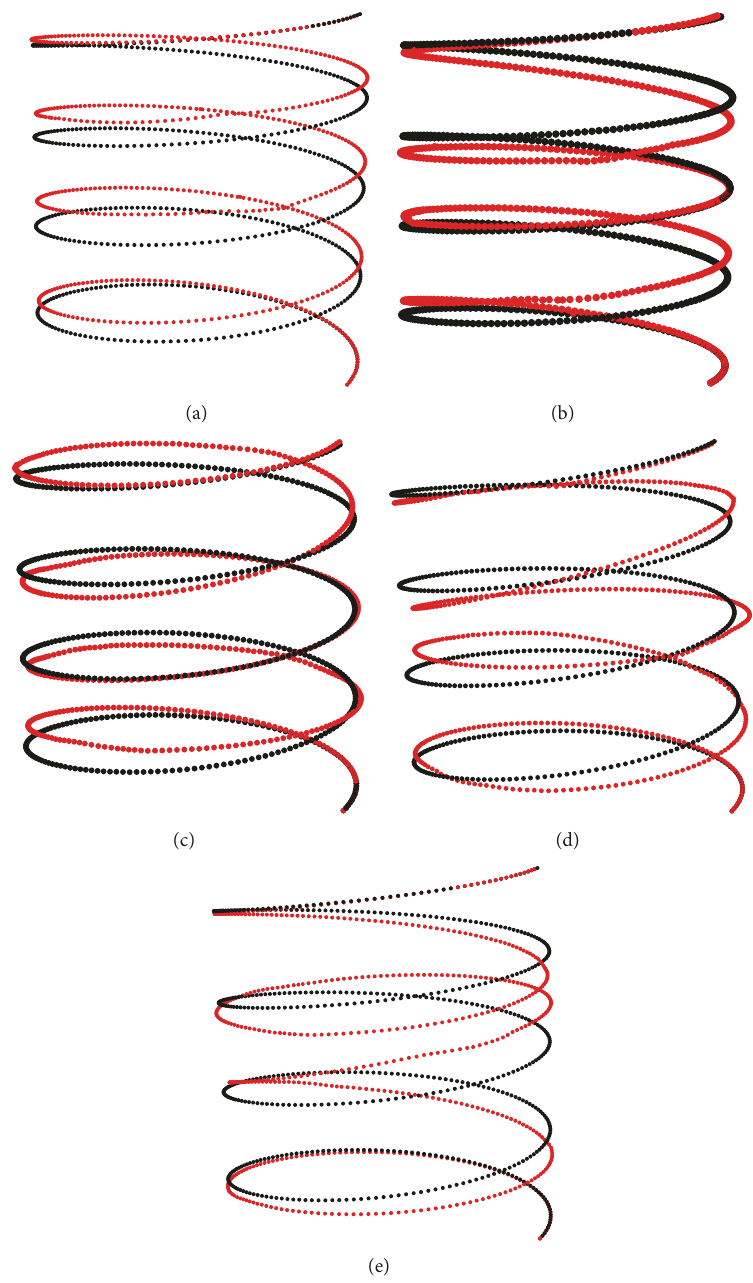
Figure 5: First five mode shapes of Beam 2 (made of unidirectional composite material): (a) first mode (358.21 Hz); (b) second mode (687.63 Hz); (c) third mode (805.74 Hz); (d) fourth mode (903.08 Hz); (e) fifth mode (958.56